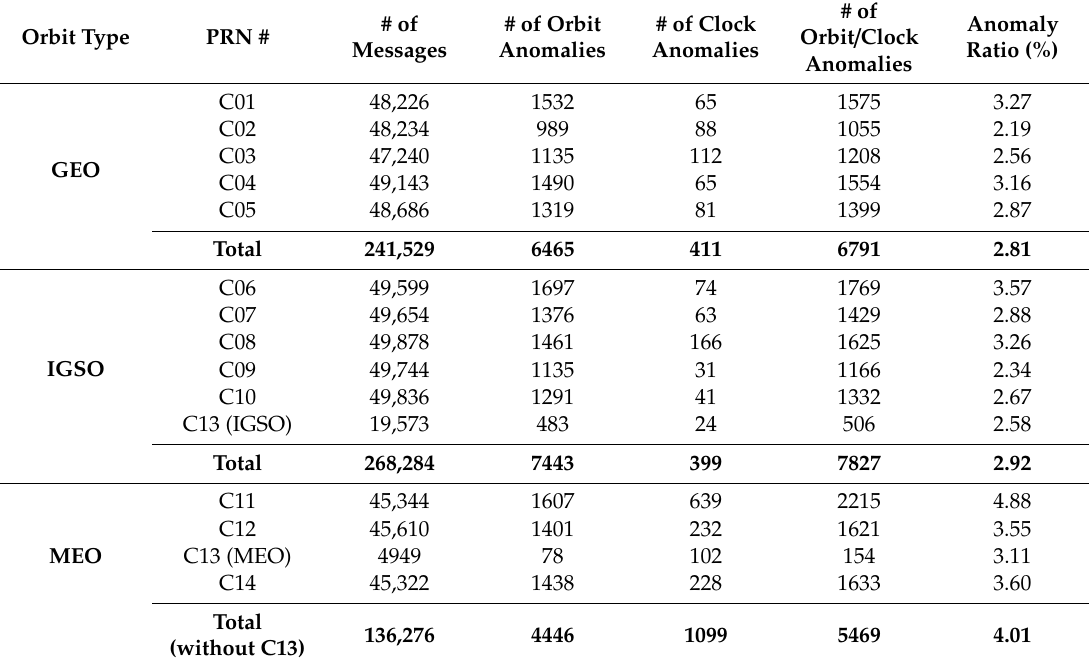
Table 2. BDS-2 anomalies detected by precise orbit / clock products.